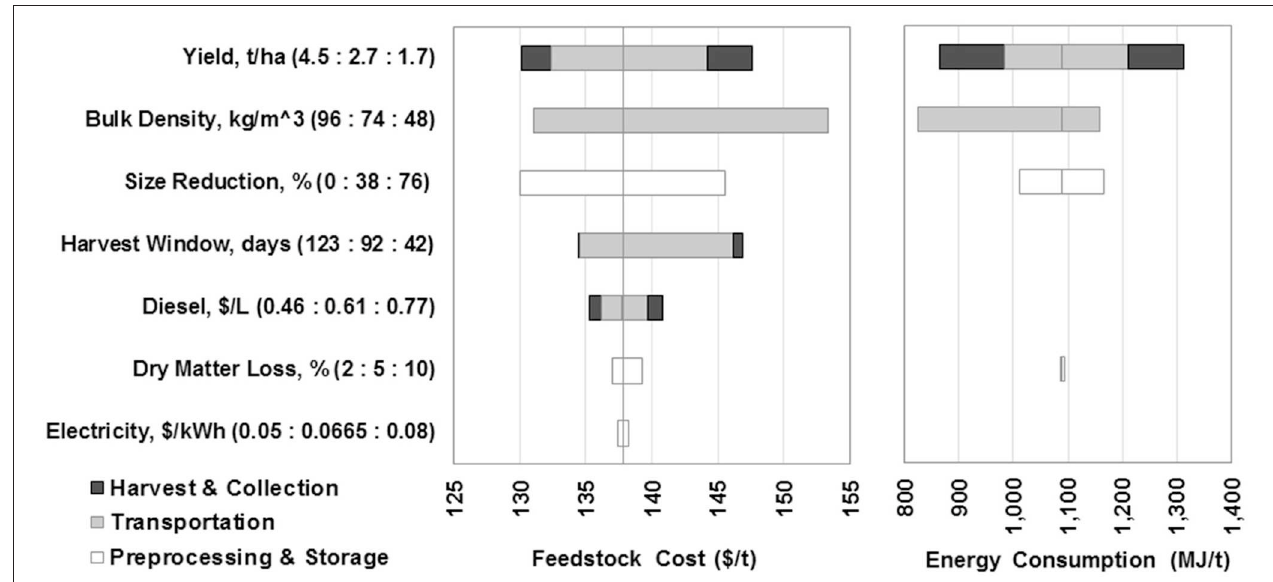
FIGURE 2 | Sensitivity analysis of feedstock cost and energy consumption to changes in yield, bulk density, size reduction necessary before conversion, harvest window, diesel fuel cost, dry matter loss in storage, and electricity cost in the chopped logistics system. Values in parenthesis represent the minimum, baseline, and maximum assumptions. Costs reported in